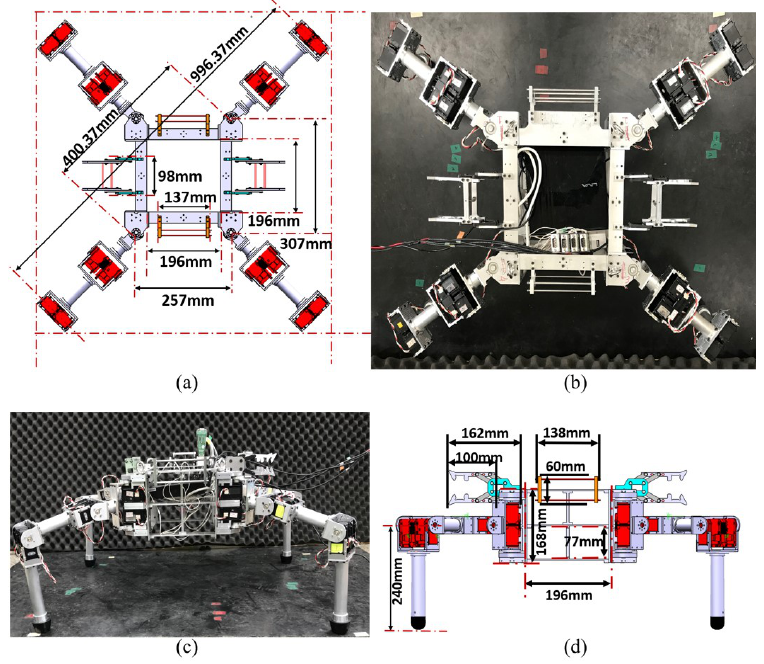
Figure 2. Design of the robot’s body. ( a ) Top view of the robot design in Catia. ( b ) Top view image of the robot. ( c ) Front view image of the robot. ( d ) Front view of the robot design in